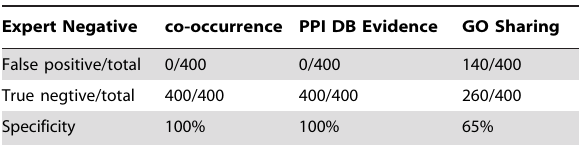
(Table 4) of PPI Finder. The co-occurrence showed a sensitivity of 92% and a specificity of 100%, which indicates that our methods of finding co-occurred genes are applicable to information extraction. The PPI database evidences showed a sensitivity of 86% and a specificity of 100%, indicating that most of the PPIs are correctly shown in the databases. The relatively lower sensitivity (66%) and specificity (65%) of GO sharing may be explained by lower stringency of GO term matches as described above, suggesting that it is not a strong indicator of PPI.